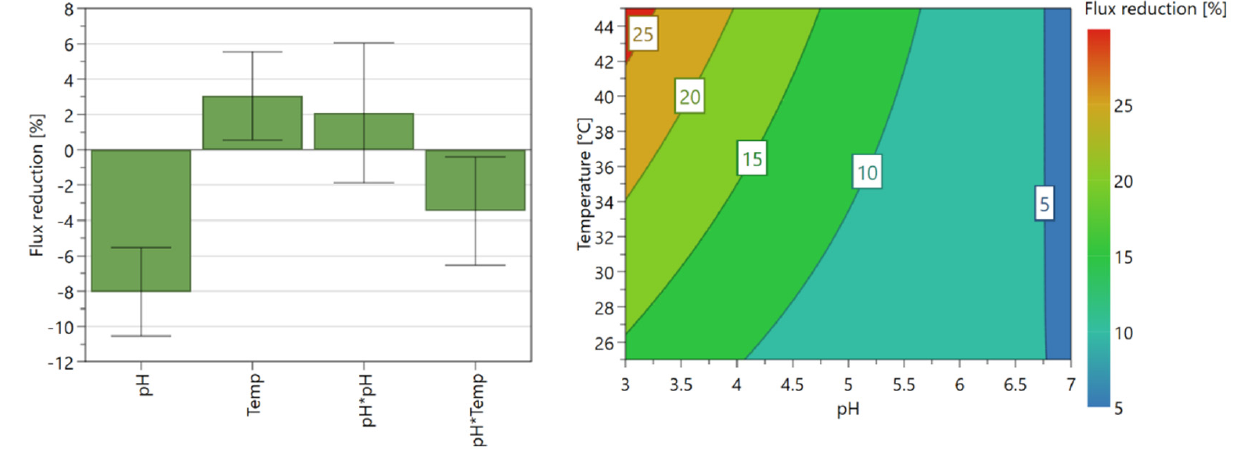
Figure 5. Coefficient plot and response contour plot for pure water flux reductions.